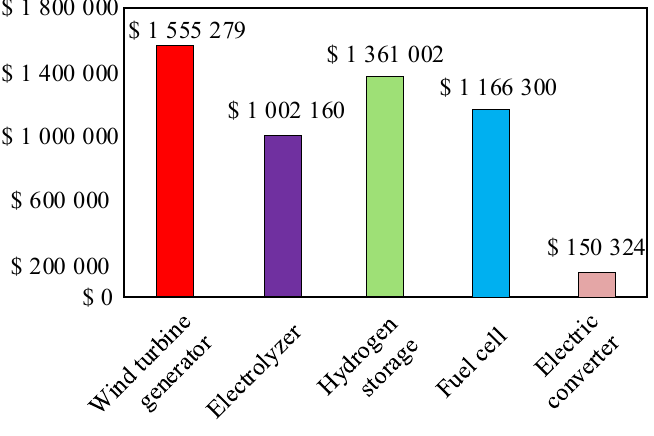
Fig. 7. Total costs separately for different system components.